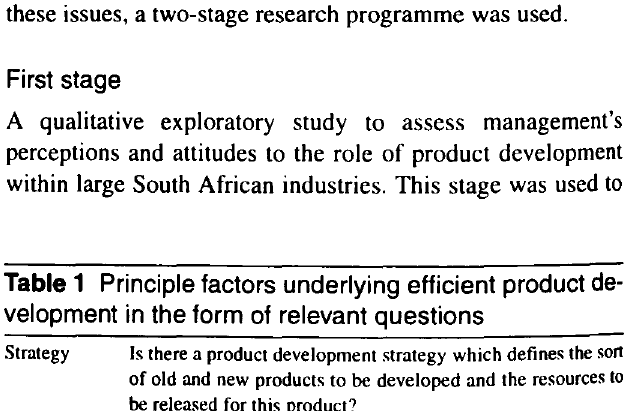
Table 1 Principle factors underlying efficient product